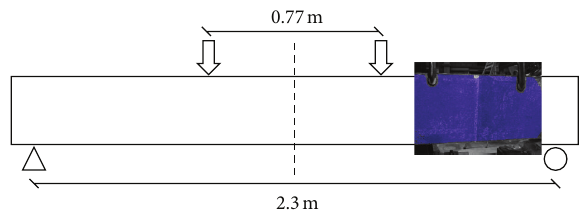
Figure 7: Location of the zone on the beam observed for crack evolution